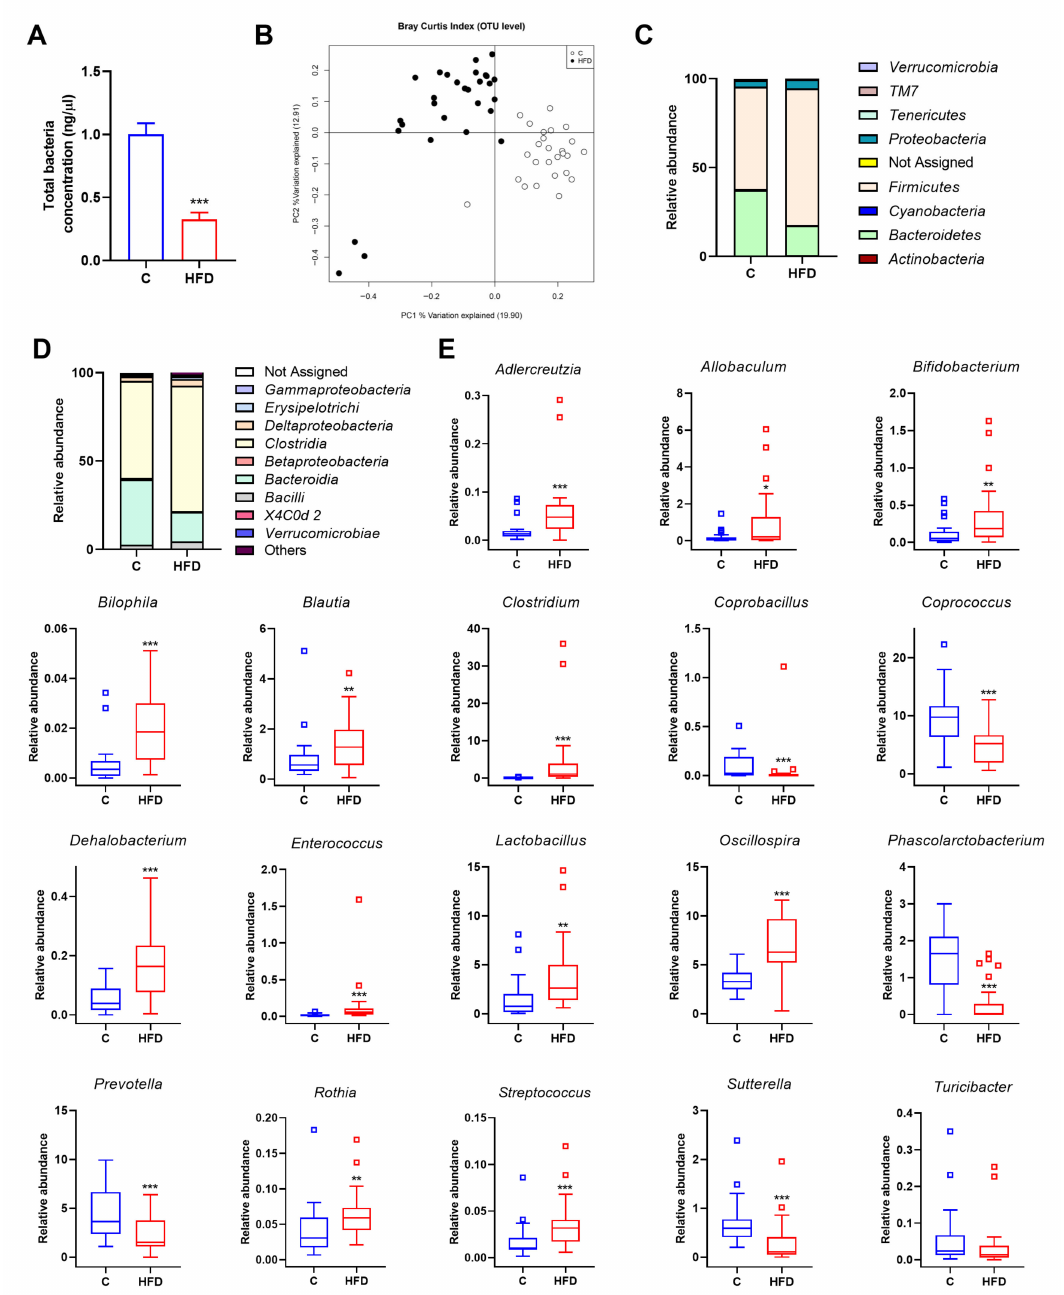
Figure 2. Effect of diet on microbiota composition in juvenile rats fed with control or HFD over six weeks. ( A ) Total bacteria concentration analysed by qPCR. Data represent mean ± SEM. *** p < 0.001 vs. C group. ( B ) Principal coordinates analysis (PCoA) plot based on Bray–Curtis dissimilarity index at the OTU level between rats fed with control or HFD. Percentage of the total variance explained is indicated in parenthesis in each axis. ( C ) Relative abundance at phylum level in the different experimental groups. ( D ) Relative abundance at class level in the different experimental groups. ( E ) Differences in the relative abundance between rats fed with control or HFD at genus level. Statistical analysis was performed using Kruskal–Wallis followed by Mann–Whitney U test ( p < 0.05). * p < 0.05, ** p < 0.01, *** p < 0.001 vs.